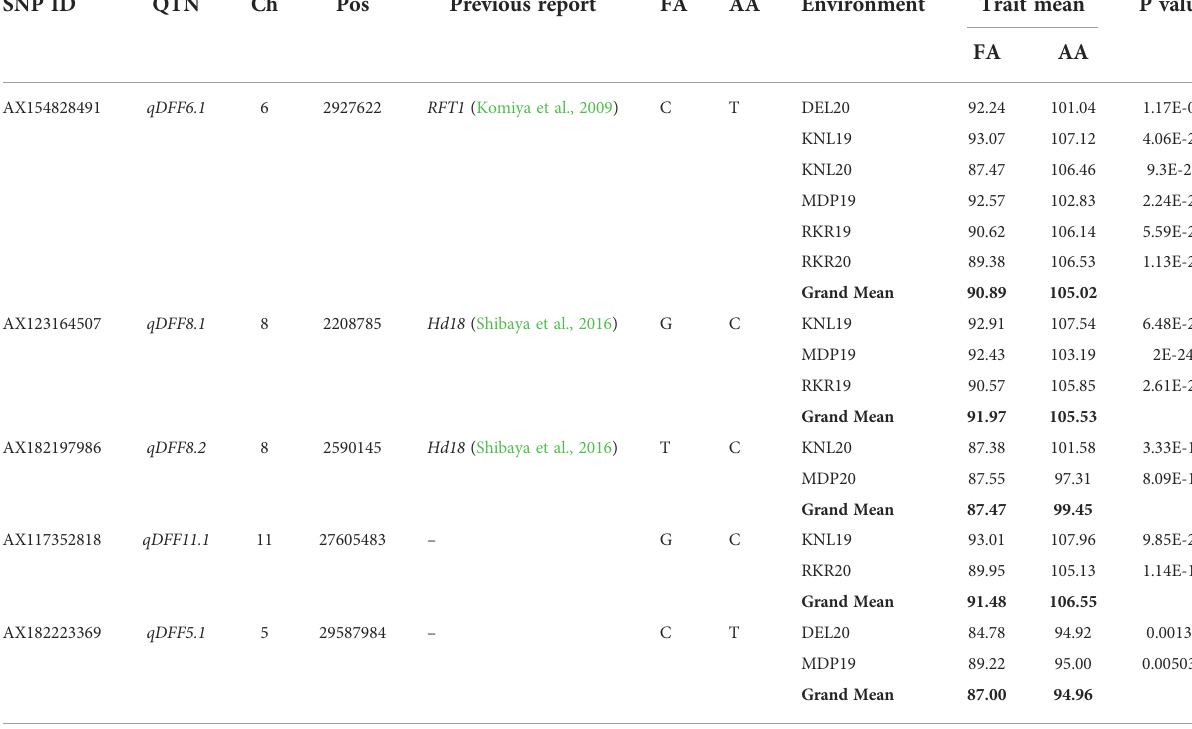
TABLE 5 Allelic effects of stable MTAs identi fi ed in multiple locations for Days to fi fty Per cent fl owering (DFF). SNP